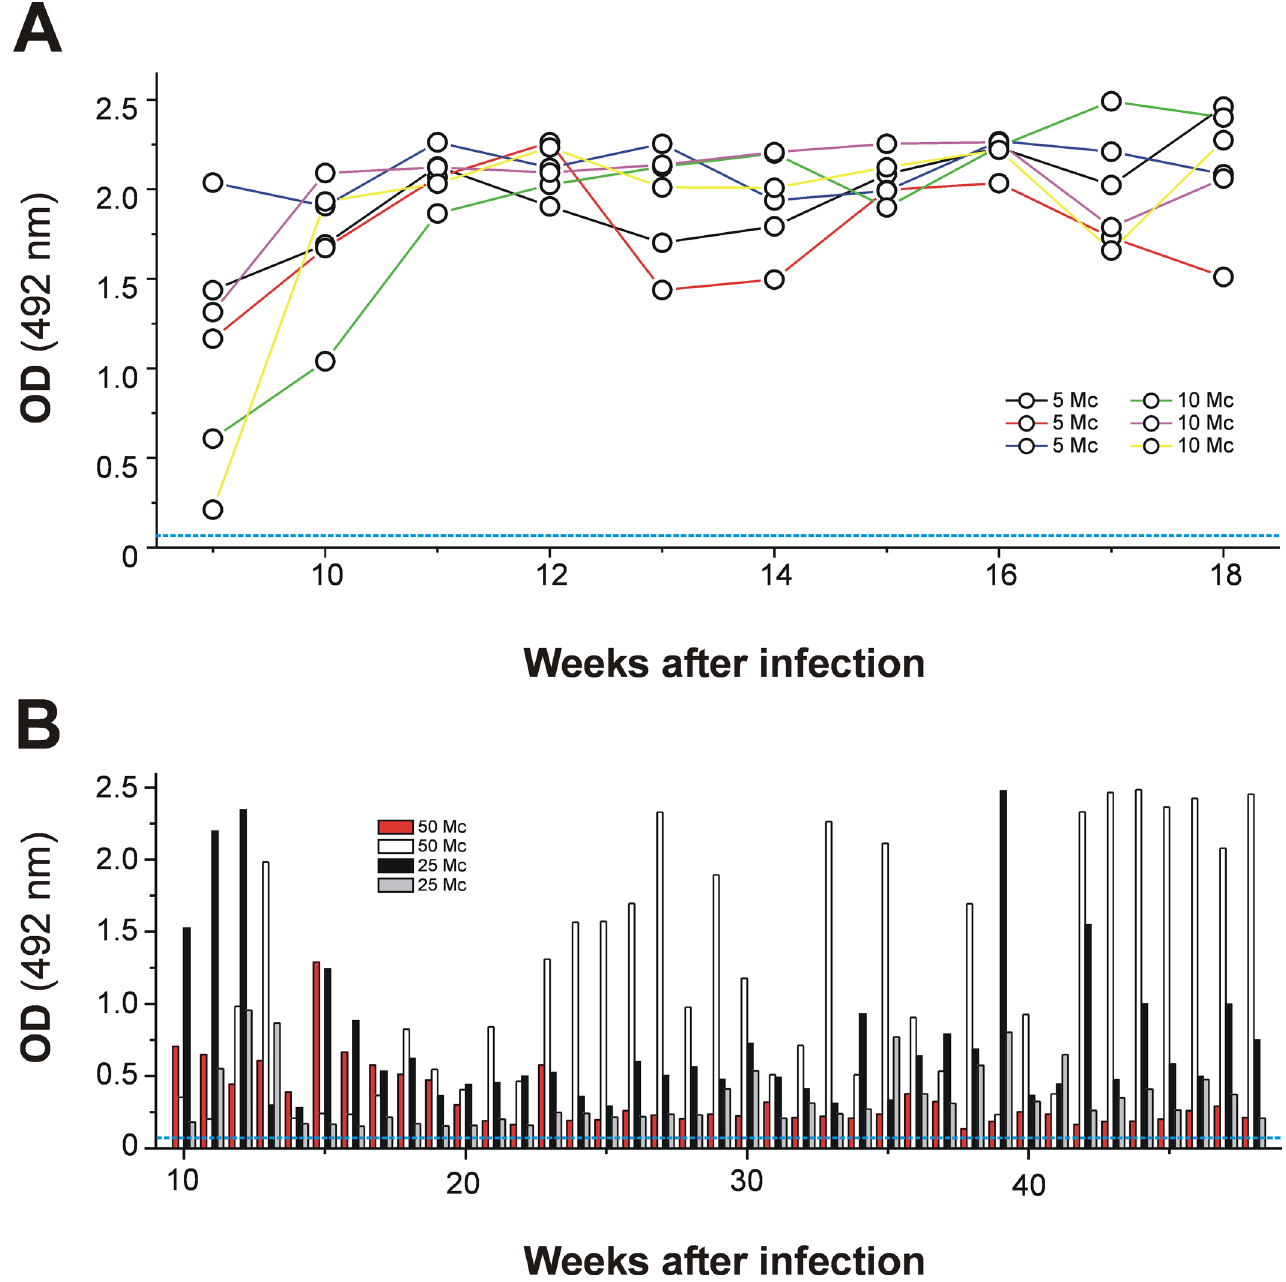
Fig 7. OD values obtained with the rapid enhanced MM3-COPRO ELISA testing fecal samples from animals experimentally infected with Fasciola hepatica . (A) Lambs were experimentally infected with 5 (n = 3) or 10 (n = 3) metacercariae. (B) Cows were infected with 25 (n = 2) and 50 (n = 2) metacercariae (Mc). Fecal samples were obtained weekly from each animal during the period of study and analyzed with the MM3-COPRO test using SA-PolyHRP and OPD and short incubations (model B). The cut-off value is 0.064 for sheep and 0.055 for